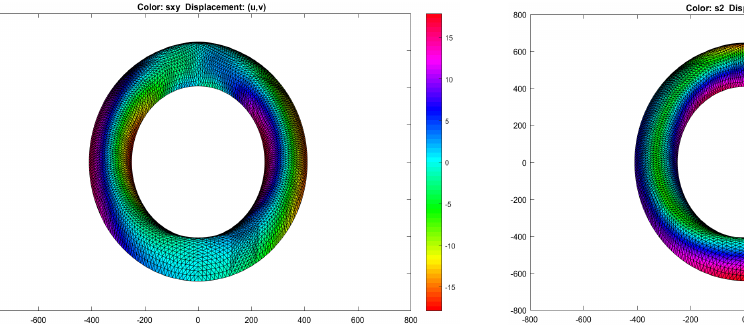
Fig. 6: Plot of the second principal stress.